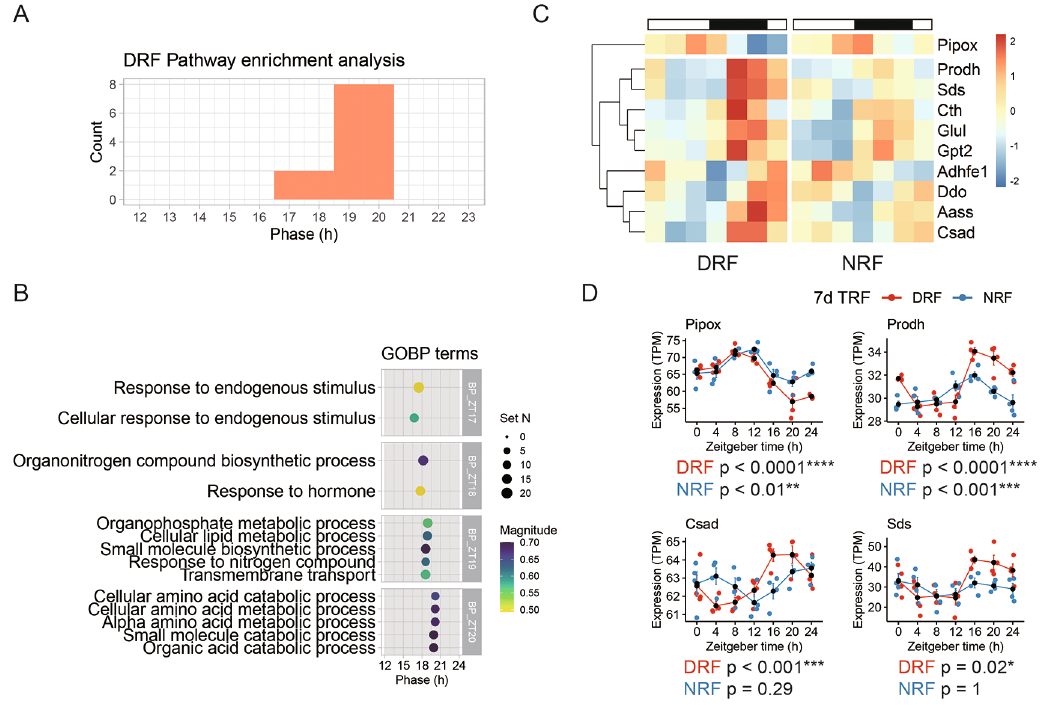
Figure3.Rhythmic pathwaysentrainedbyDRFintheanteriorhypothalamus. (A)Phasedistributionofenriched rhythmic pathways based on the anterior hypothalamic diurnal transcriptome. (B) Representative rhythmic path- ways that peak around zeitgeber time 18.5 h (ZT18.5). (C) Diurnal expression profiles of the rhythmic genes involved incellularaminoacidmetabolism.(D)Representativerhythmictranscriptsrelatedtocellularaminoacidmetabolism. Data are presented as mean (cid:1) SEM (n = 4 mice per time point for seven time points). MetaCycle method, *BH adjusted p-value < 0.05, **p < 0.01, ***p < 0.001, ****p < 0.0001. NRF, night time-restricted feeding ; DRF, day time- restricted feeding; GOBP, gene ontology biological processes; Pipox, Pipecolic acid and sarcosine oxidase; Prodh, Proline dehydrogenase 1; Csad, Cysteine sulfinic acid decarboxylase; Sds, Serine Pipox transcript encoding pipecolic acid and sarcosine oxidase, an essential enzyme in lysine degradation-forms one cluster by itself,which peakedinthelatesleepphase (Figure 3D). Proline dehydrogenase1( Prodh )transcript encodes the first enzyme in proline degradation. Cysteine sulfinic acid decarboxylase ( Csad ) is an enzyme in cysteine and methionine degradation. Serine dehydrastase ( Sds ) catalyzes serine and threonine degradation. As shown in Figure 3D, transcripts of Prodh, Csad, and Sds exhibited robust diurnal oscillation in anterior hypothalamus of DRF mice. In particular, Csad and Sds did not oscillate in NRF. Thus, transcript signatures suggest that DRF entrains diurnal rhythms of cellular amino acid degradation.